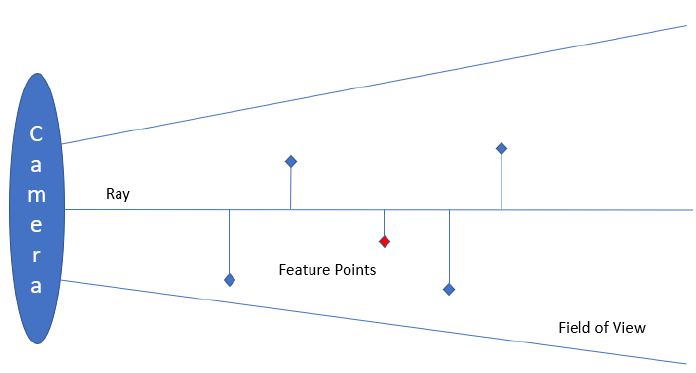
Figure 6. A ray cast from the camera through a field of trackable feature points. The red point is the one chosen by the algorithm, since its distance from the ray is the